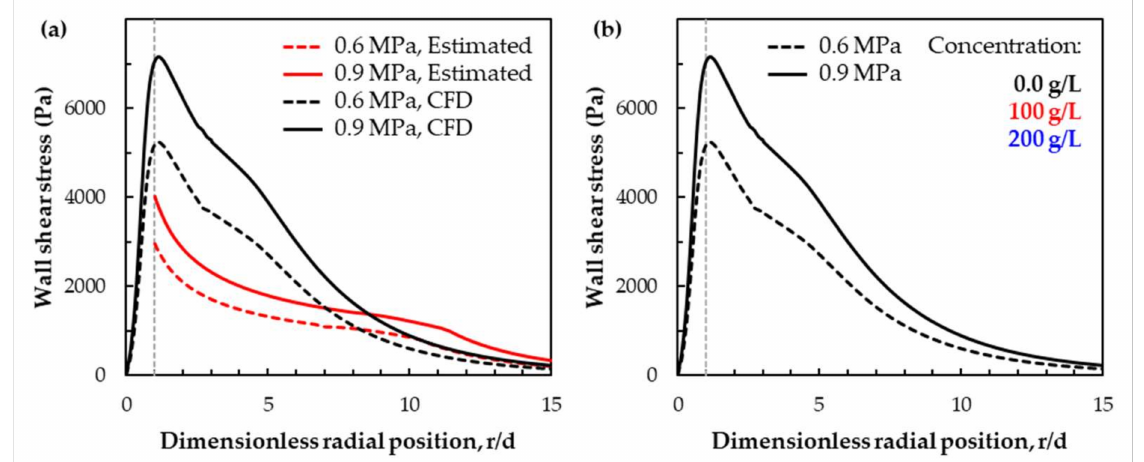
Figure 15. Wall shear stress generated by the liquid suspension on the workpiece surface; ( a ) com- parison between numerical results (red lines) and empirical approach (black lines); ( b ) comparison between different operating conditions and particle concentrations. Varying the particle concentration has no effects on the wall shear stress, and the curves overlap each other.